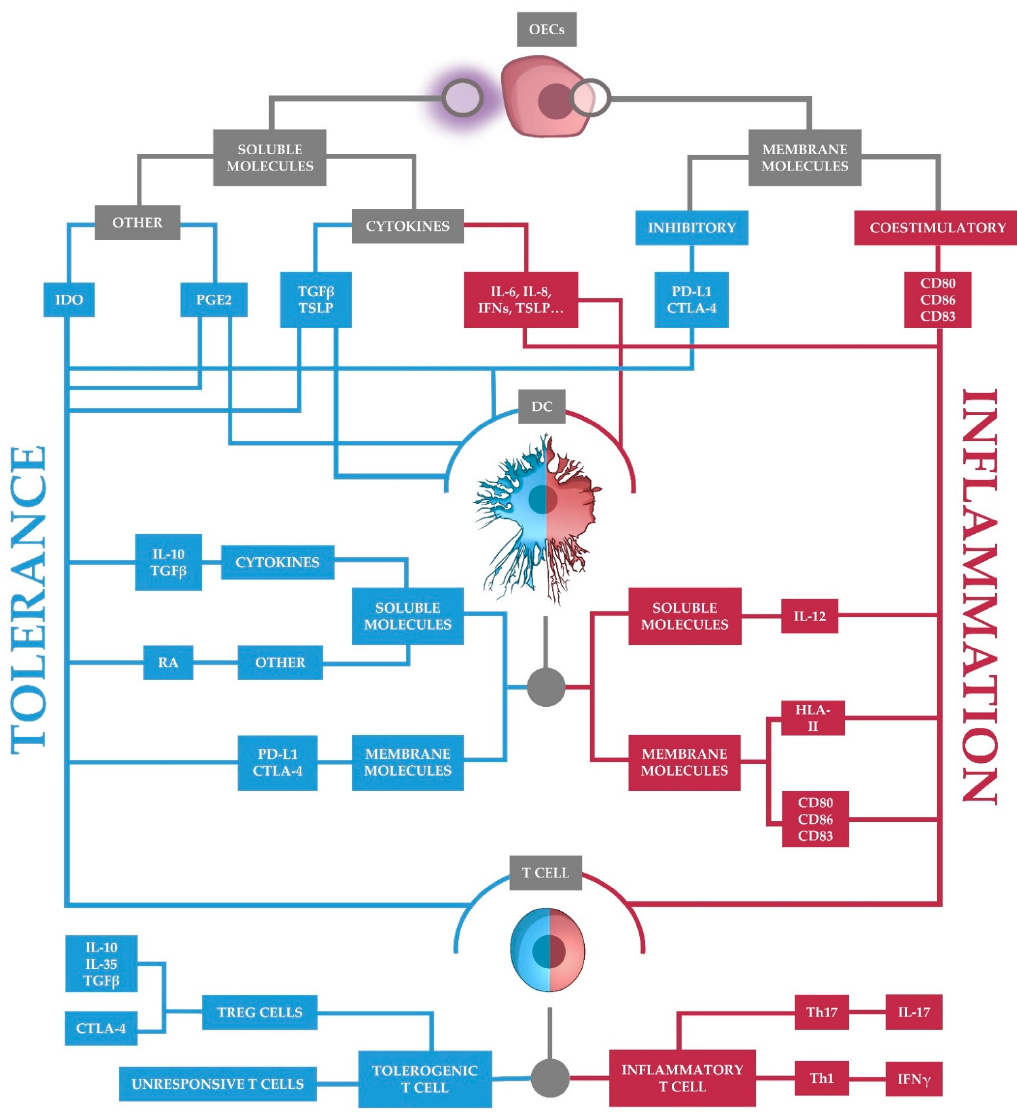
Figure 3. Mechanisms of immune tolerance in the oral mucosa. OECs secrete soluble molecules and express surface proteins that modulate immune responses. They condition DCs to become tolerogenic (blue), which promotes Treg differentiation, but can also promote the recruitment of inflammatory DCs (red). OECs also condition T cell responses by suppressing T cell responses (blue).